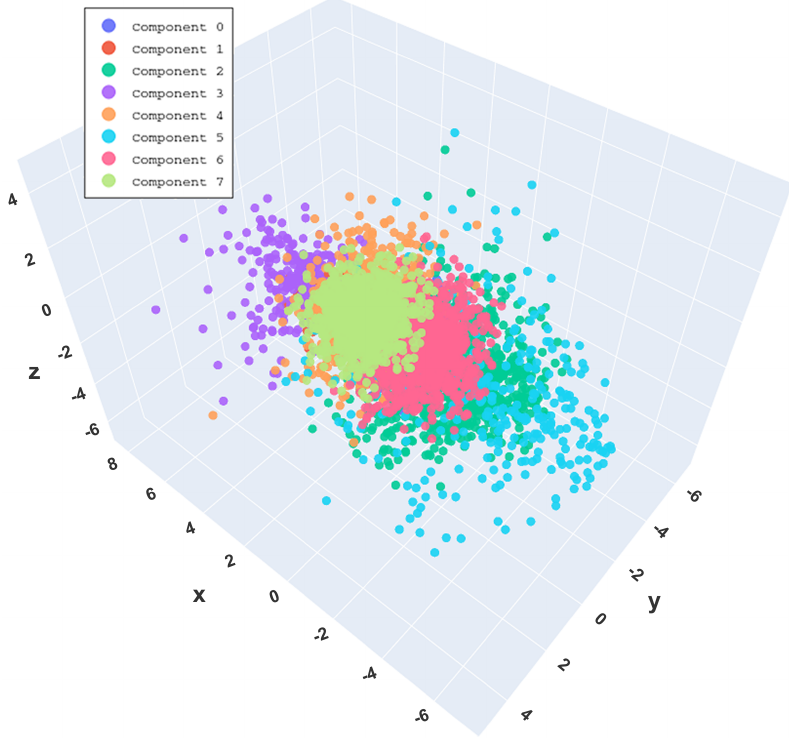
Figure 8. Plot 3D using technique Linear Discriminant Analysis applied over the 30-days summariza- tion